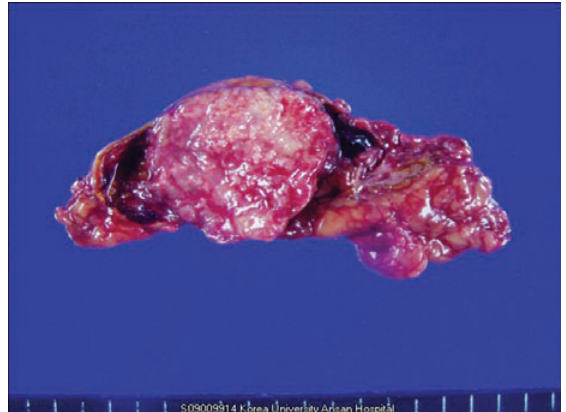
Figure 3. Macroscopically, the tumor was 3.5 x 3.0 cm in size, and its cross-section showed that nearly all the adrenal gland had been replaced by a